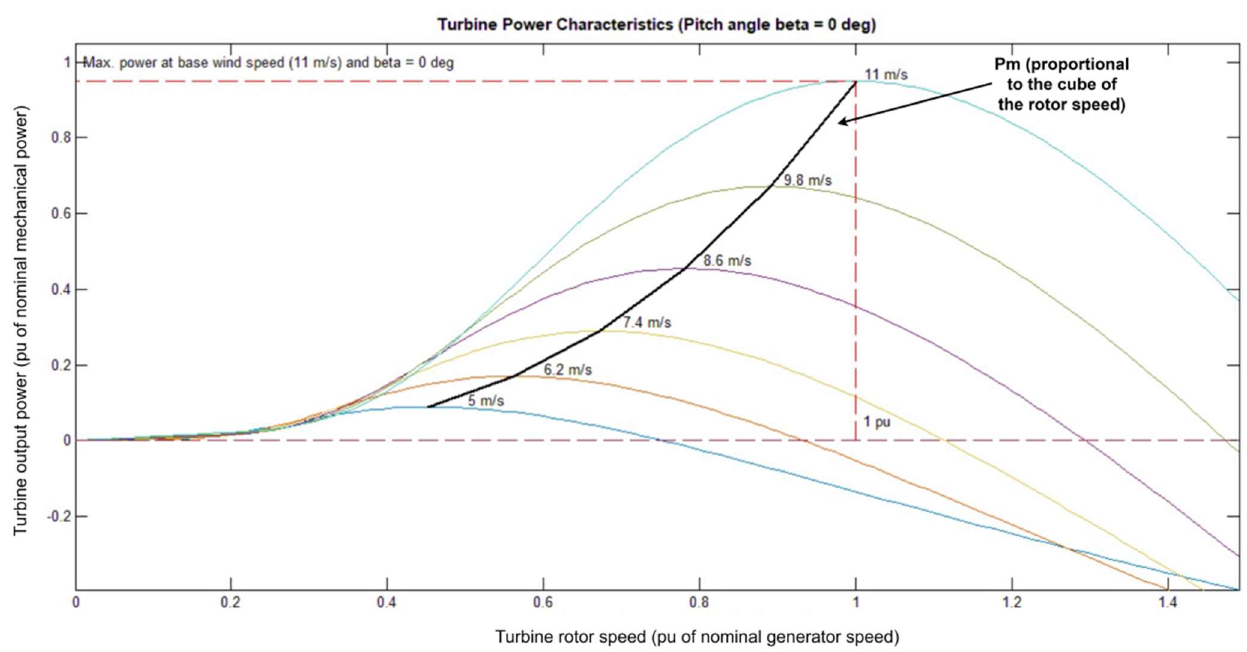
Figure 4. Mechanical power curves versus rotor rotational speed as a function of wind speed.